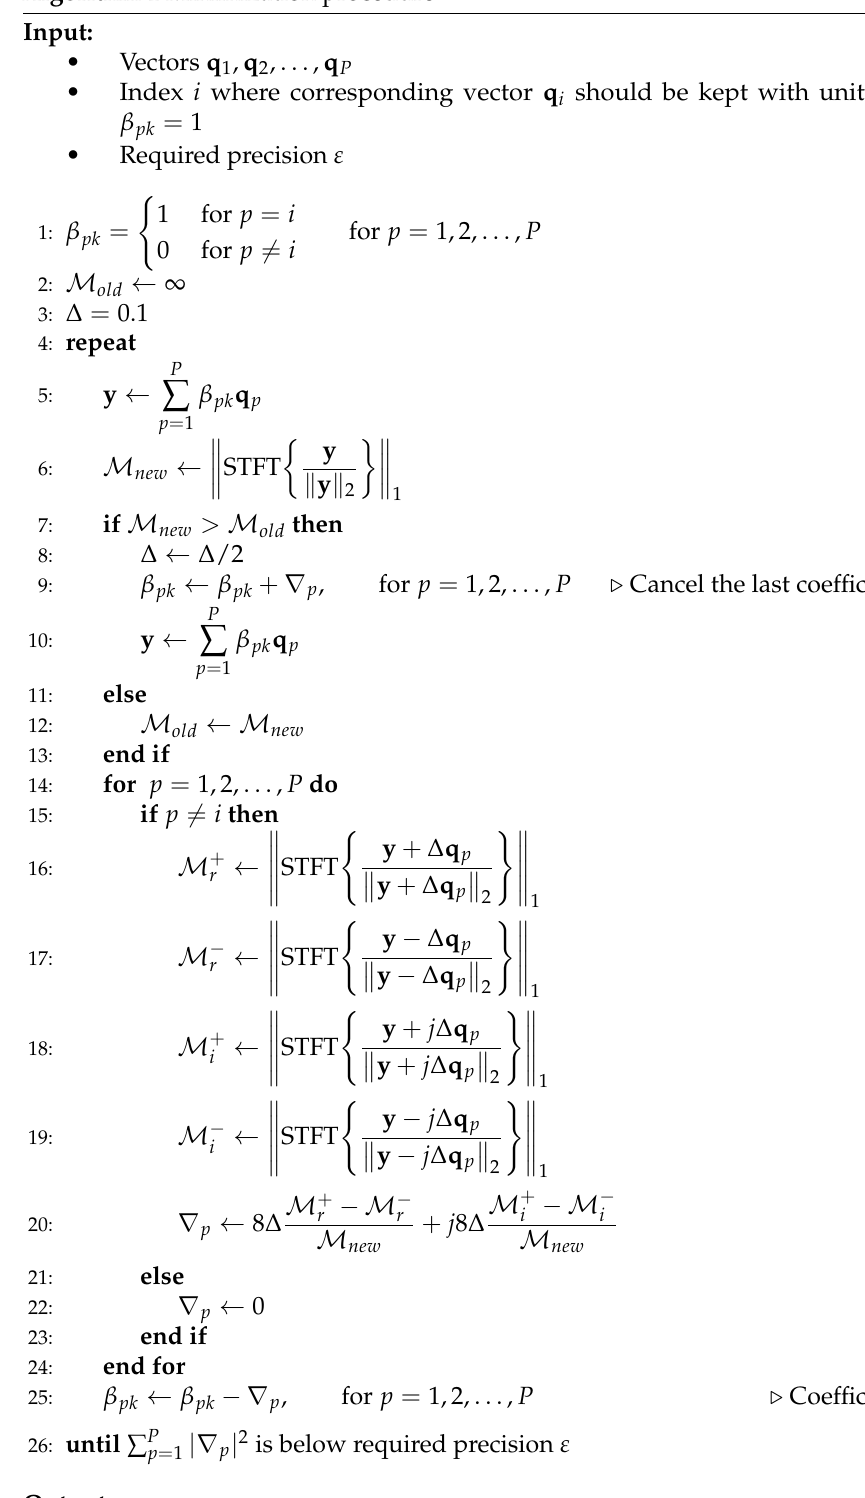
Algorithm 1 Minimization